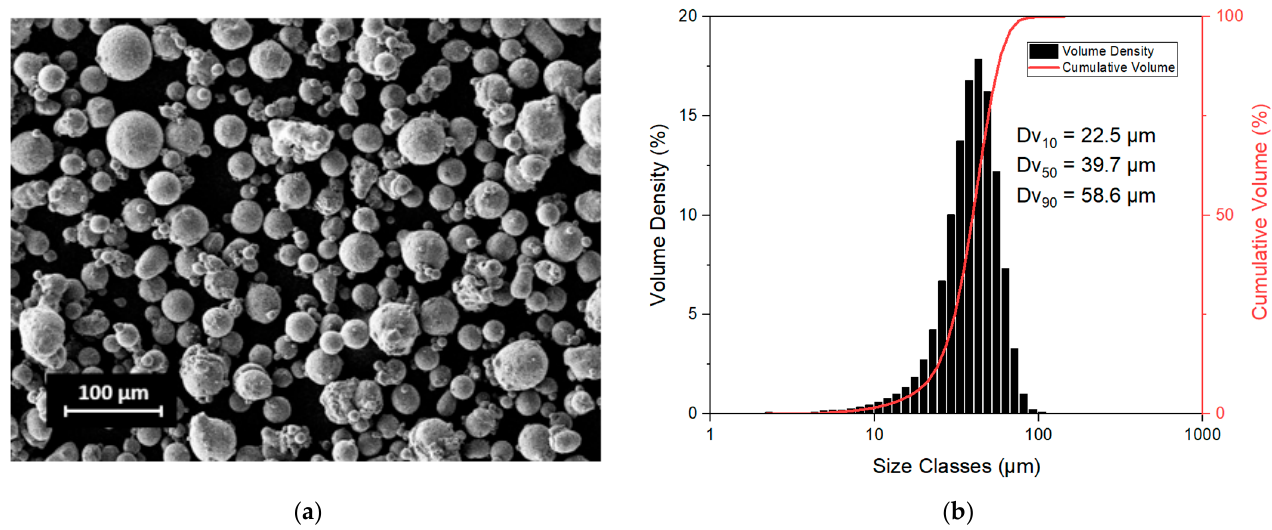
Figure 1. Powder morphology observed with SEM ( a ) and particle size distribution ( b ).